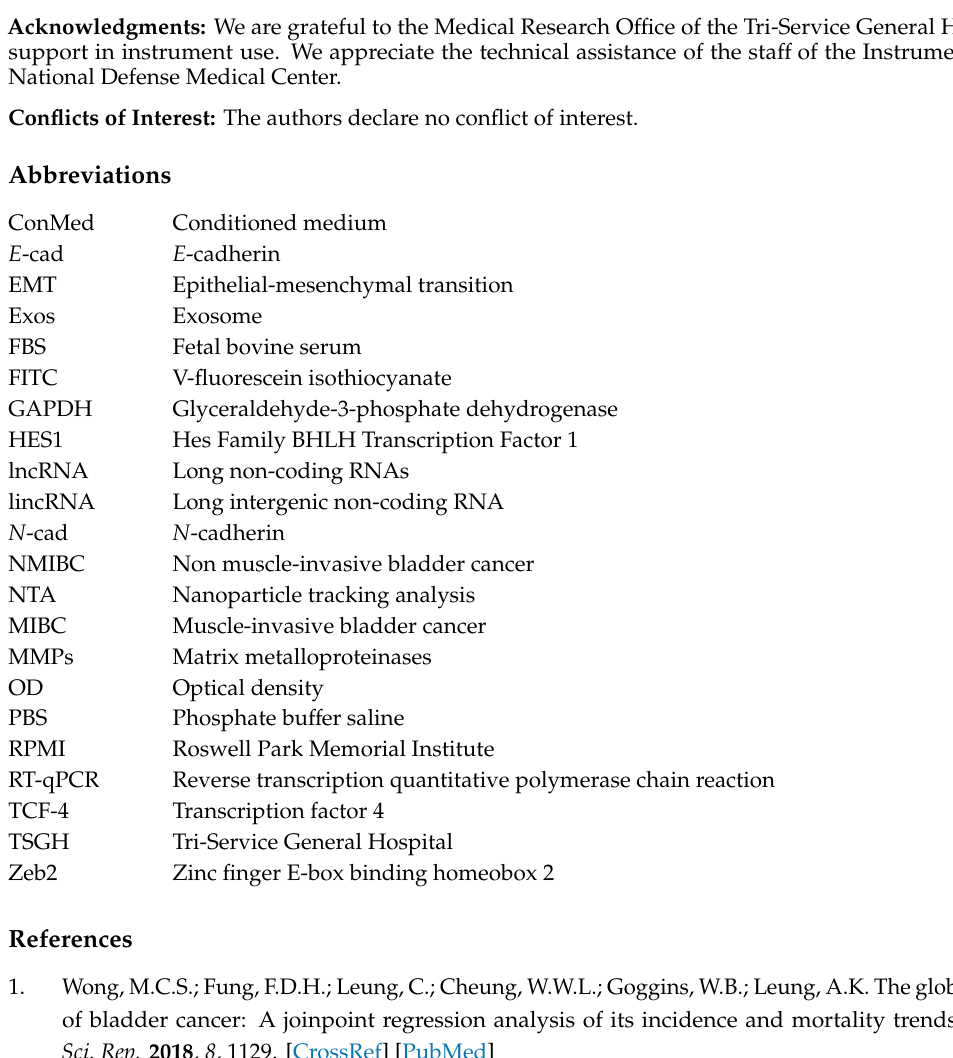
Figure S1, Figure S2, Table S1: Primer sequences in the study, Video S1: Exosome uptake under PBS treatment, Video S2: Exosome uptake under TSGH8301-Exos treatment, Video S3: Exosome uptake under T24-Exos treatment, Video S4: Exosome uptake under J82-Exos